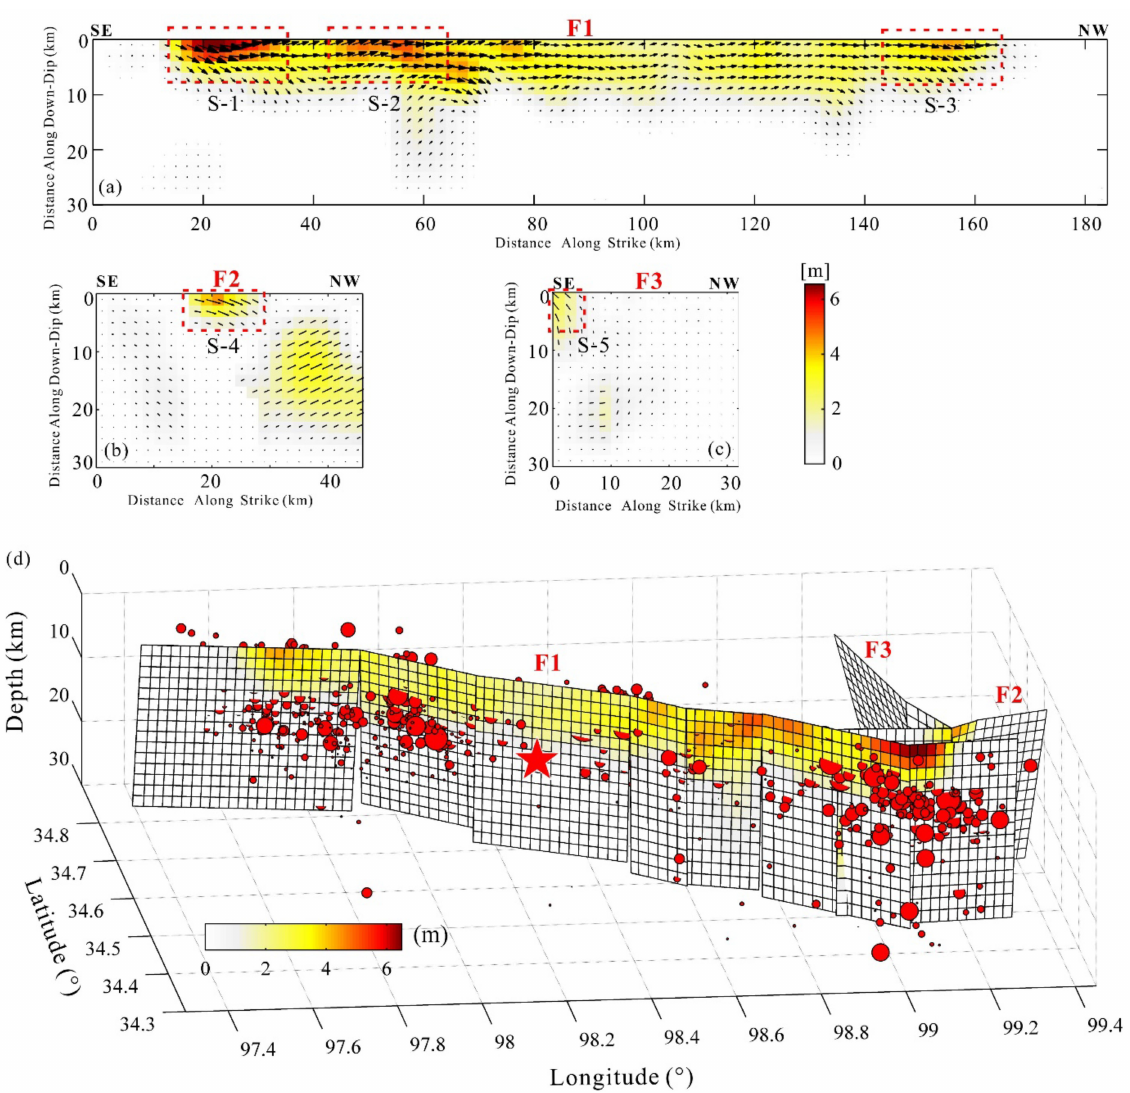
Figure 9. Estimated faulting model of the 2021 Mw 7.3 Maduo earthquake. The inferred fault slip distribution on the seismogenic fault of F1 ( a ), F2 ( b ) and the Changmahe fault ( c ). ( d ) The 3D view of the fault slip and aftershock distribution. Red star indicates the hypocenter of the 2021 Maduo Mw 7.3 earthquake, and red circles denote the aftershocks after the main shock. F1–F2 indicate the two main seismogenic faults, and F3 is the Changmahe